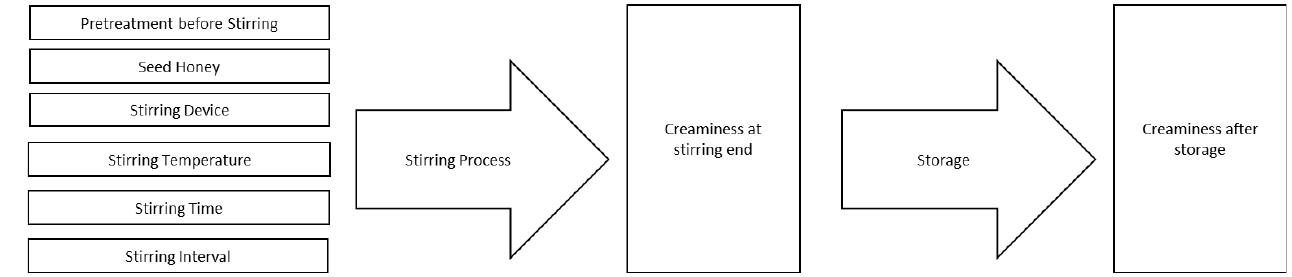
Figure 6. Interaction of the stirring process parameters and storage to the creaminess of honey rich in glucose.